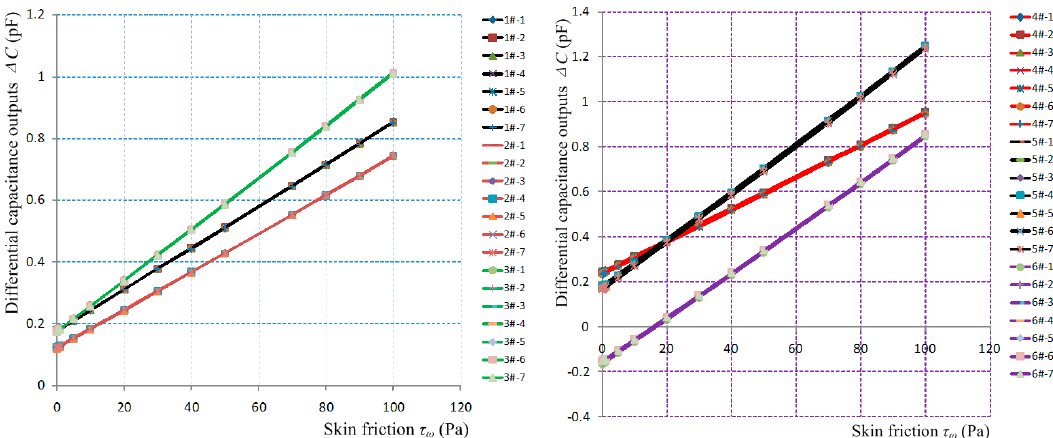
Figure 10. Static calibration curves for sensor prototypes. Table 2. The performance indexes of sensor prototypes static calibration.